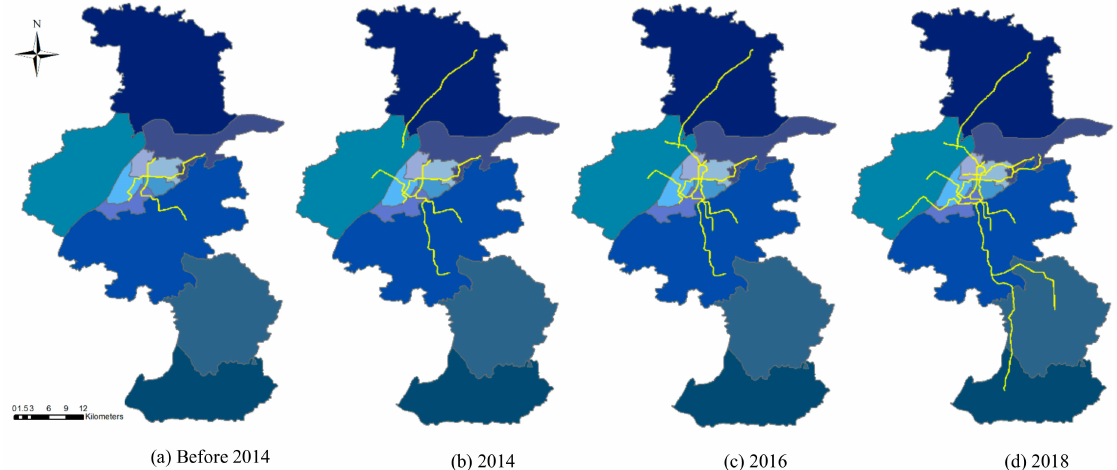
Figure 3. The annual change in the subway network of Nanjing. Notes: ( a – d ) map the subway network of Nanjing at the end of 2013, 2014, 2016, 2018,